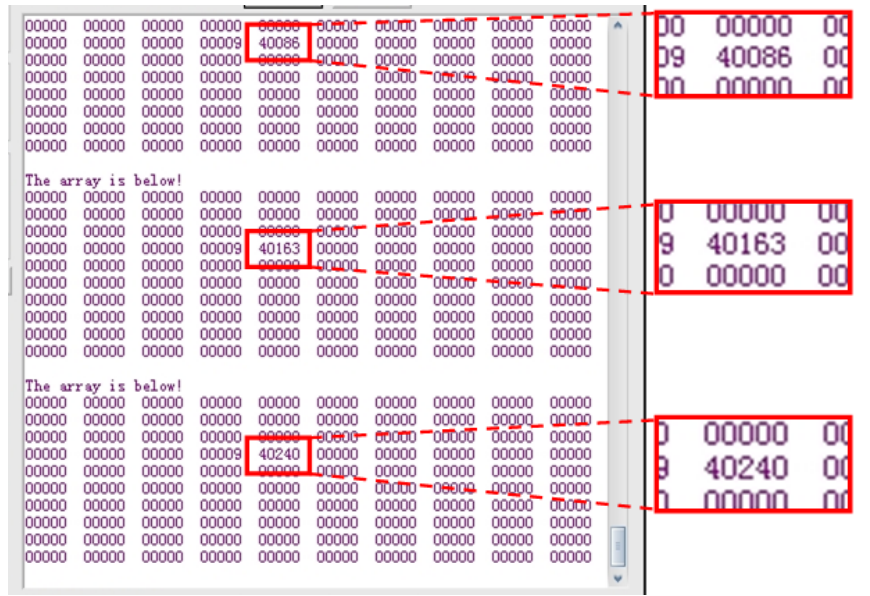
Figure 12. Screenshot of the wireless transceiver